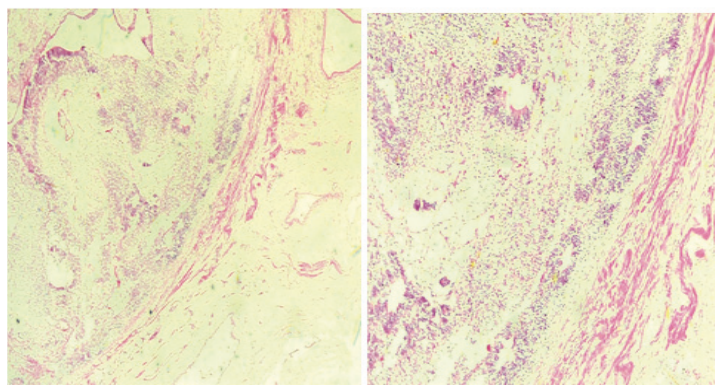
Figure 1: Case one: a 23-year-old woman with right ovarian